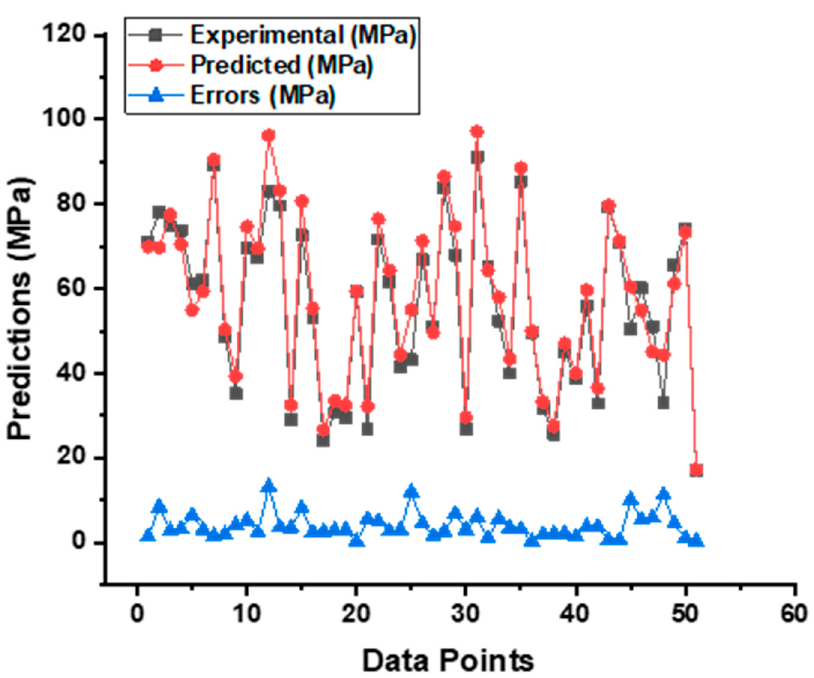
Figure 14. Indication of the error’s difference between the actual and forecasted CS result of SCC from BR model.